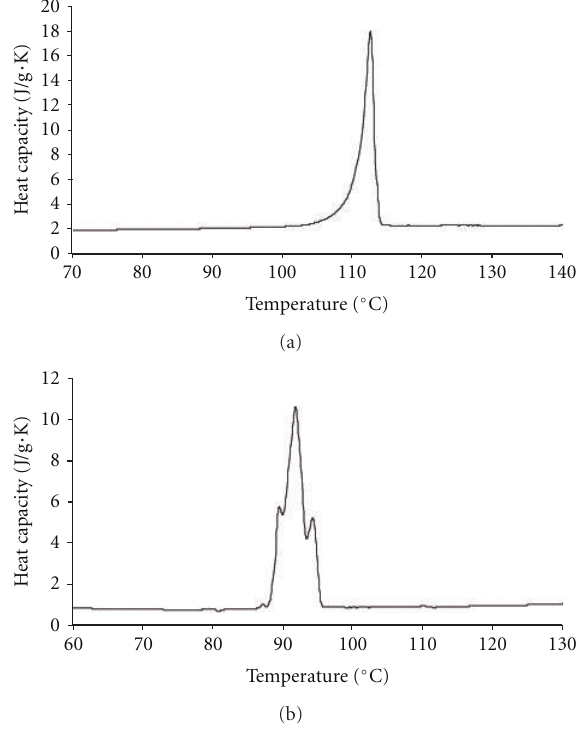
Figure 1: DSC thermograms of cholesteryl acetate at a rate of 10K · min − 1 , (a) heating, (b)